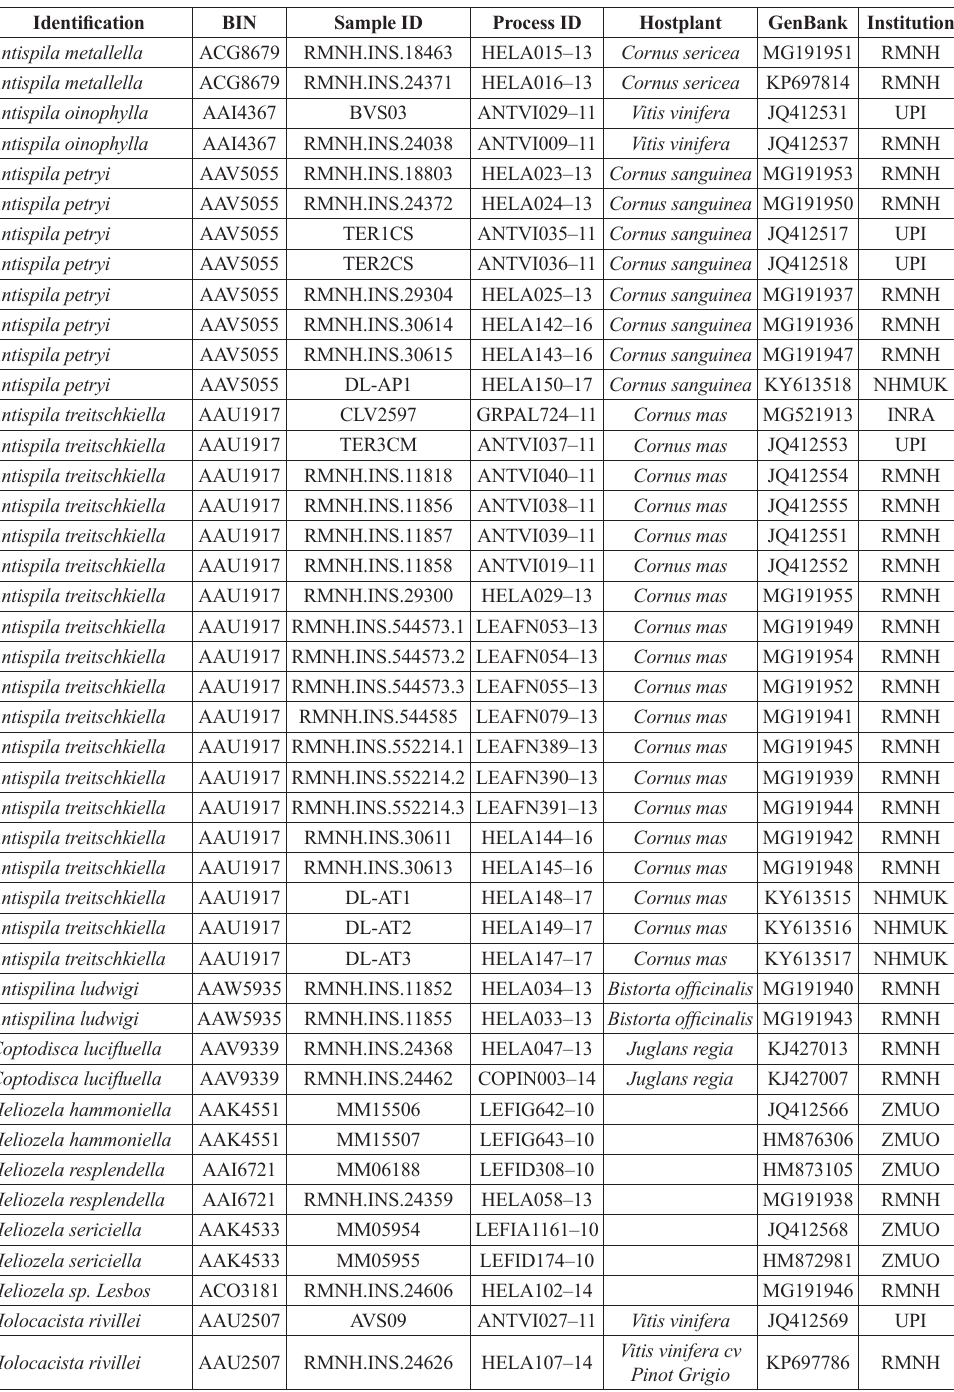
Table 1. Material of Heliozelidae used for DNA barcodes, all in dataset DS-ANTITR, doi: